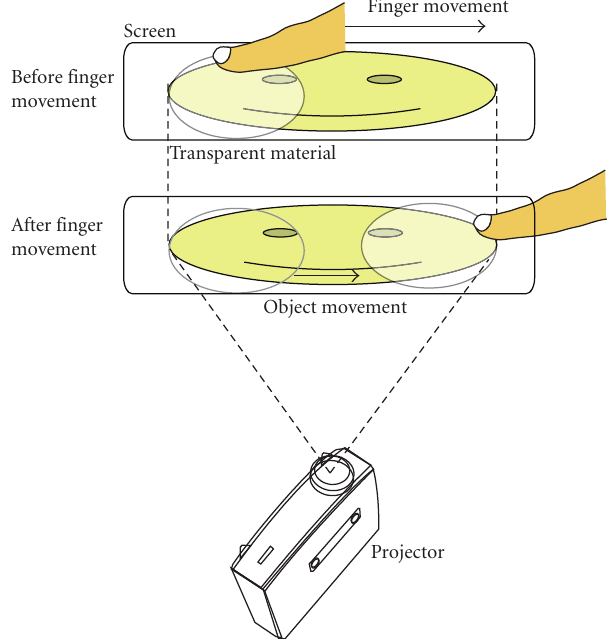
Figure 8: Principle for achieving a visual-tactile function with the